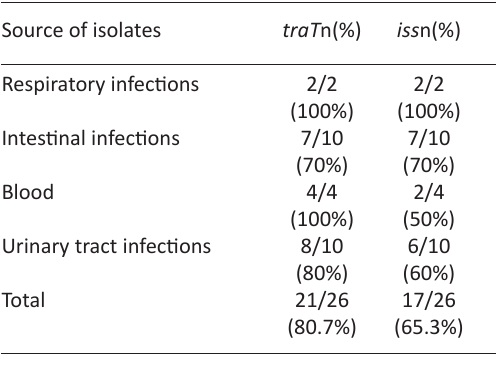
Table 2. The dissemination of genes among bacterial isolates according to the site of